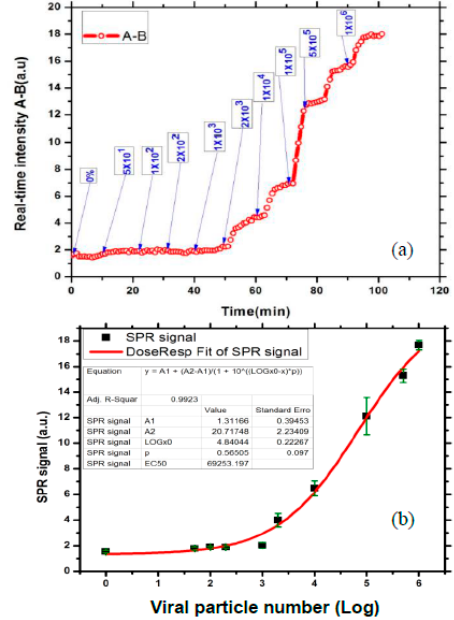
Figure 3. ( a ) Real-time normalized SPR signal with different concentration EV71 viral particles; ( b ) Curve fitting of measured series concentrations of EV71 virus particle sample as standard curve using variable slope dose-response